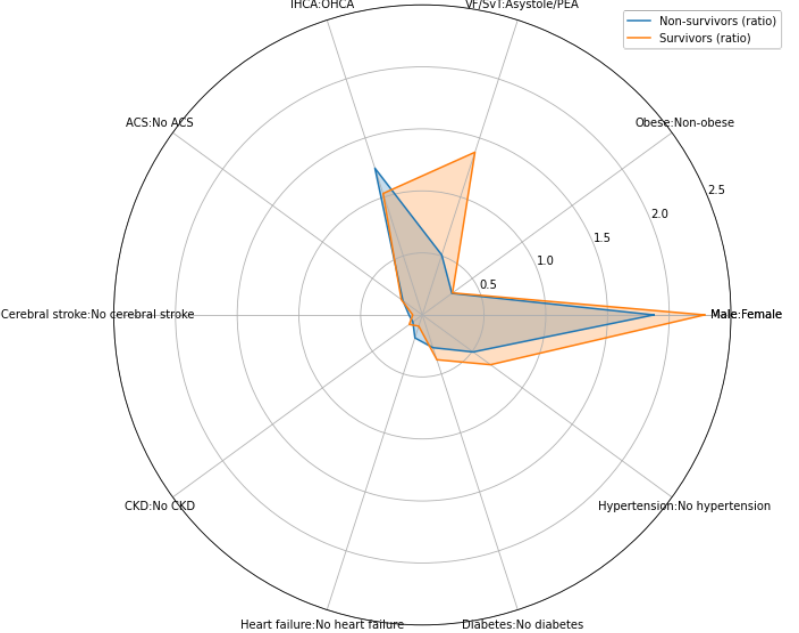
Figure 2. Radar plot of comorbidity incidence and sex. Lines and colored areas mark the count ratios. ACS, acute coronary syndrome; HF, heart failure; DM, diabetes mellitus; CKD, chronic kidney disease; CS, cerebral stroke; HT, hypertension; OHCA, out-of-hospital cardiac arrest; IHCA, in-hospital cardiac arrest; PEA, pulseless electrical activity; VF, ventricular fibrillation (VF); pVT, pulseless ventricular tachycardia. pulseless ventricular tachycardia.